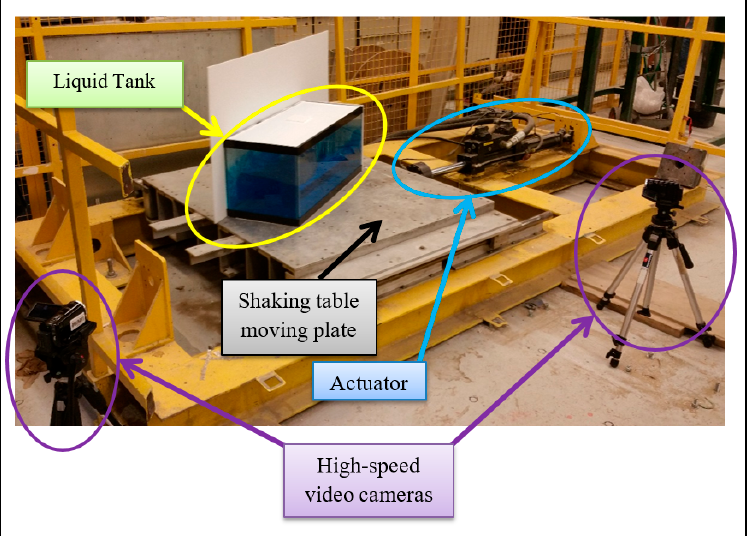
Figure 3. The experimental test setup: liquid container, uni-directional shaking table, and high-speed video cameras.